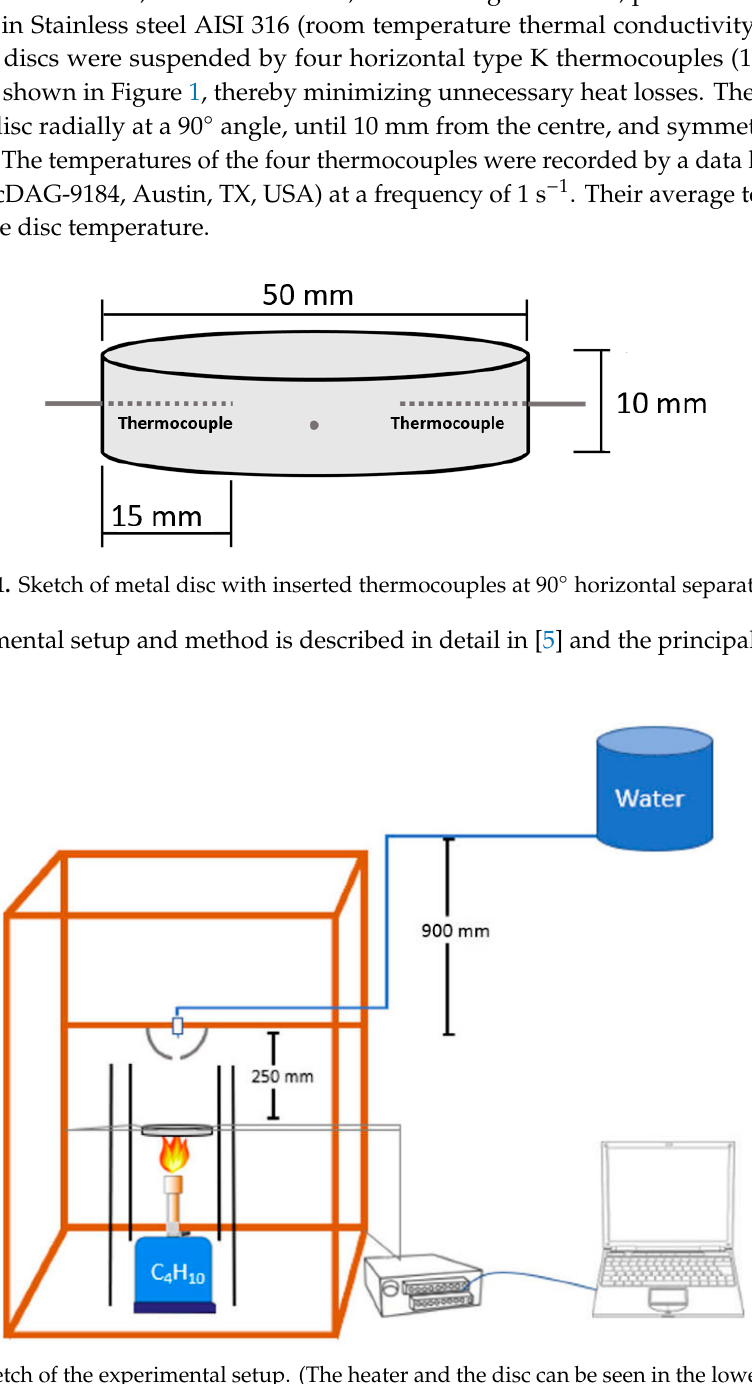
Figure 2. Sketch of the experimental setup. (The heater and the disc can be seen in the lower part of the air draft limiting frame).